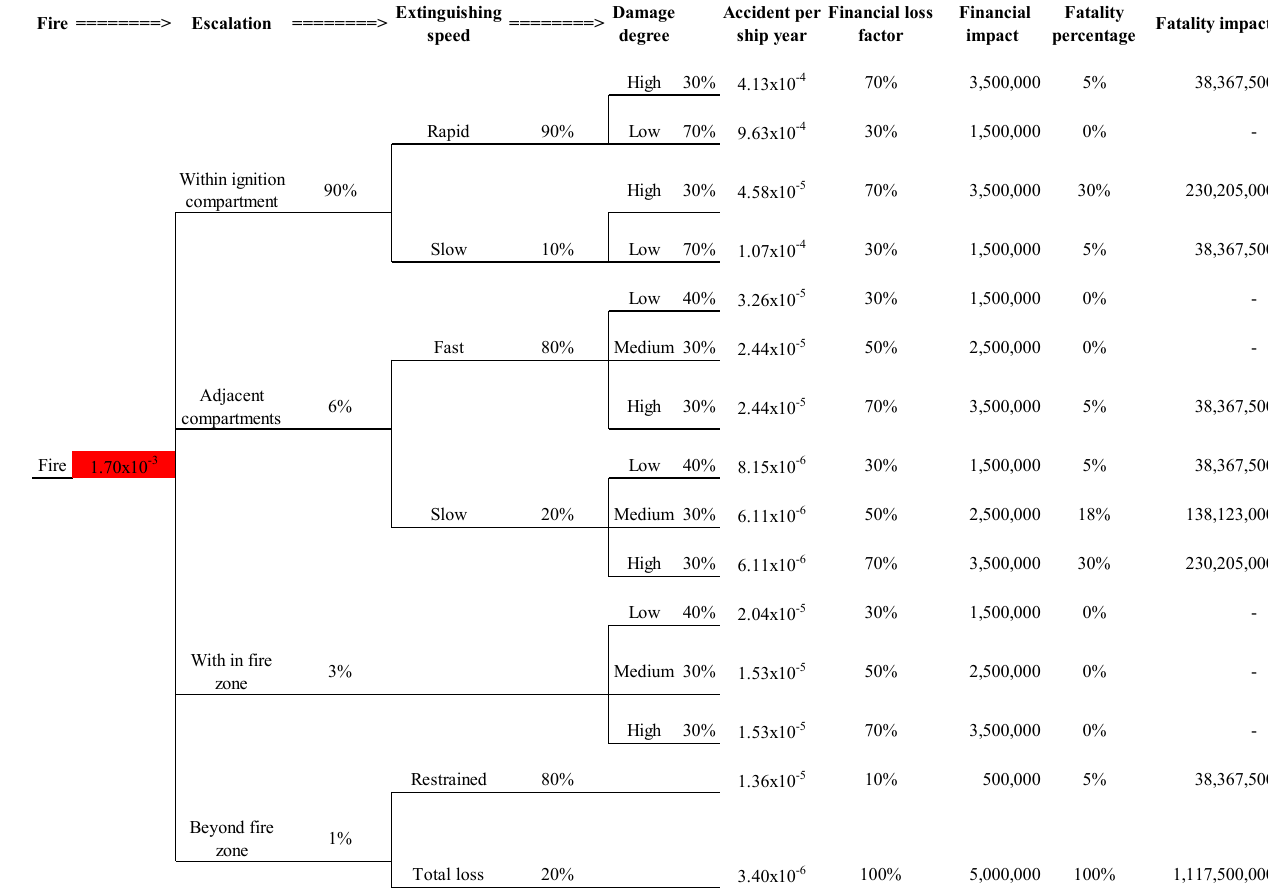
Figure 18. Event tree analysis of contact for the ferry in this study.